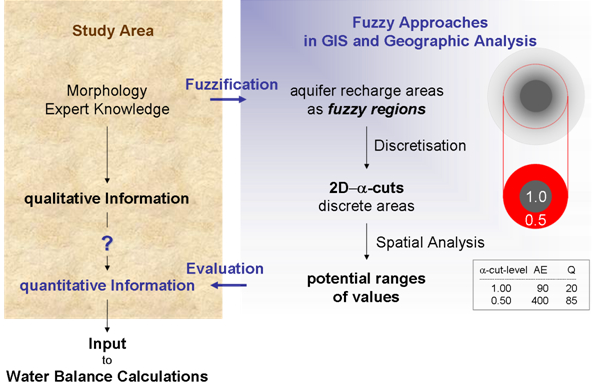
Fig. 2. The concept of fuzzy recharge areas